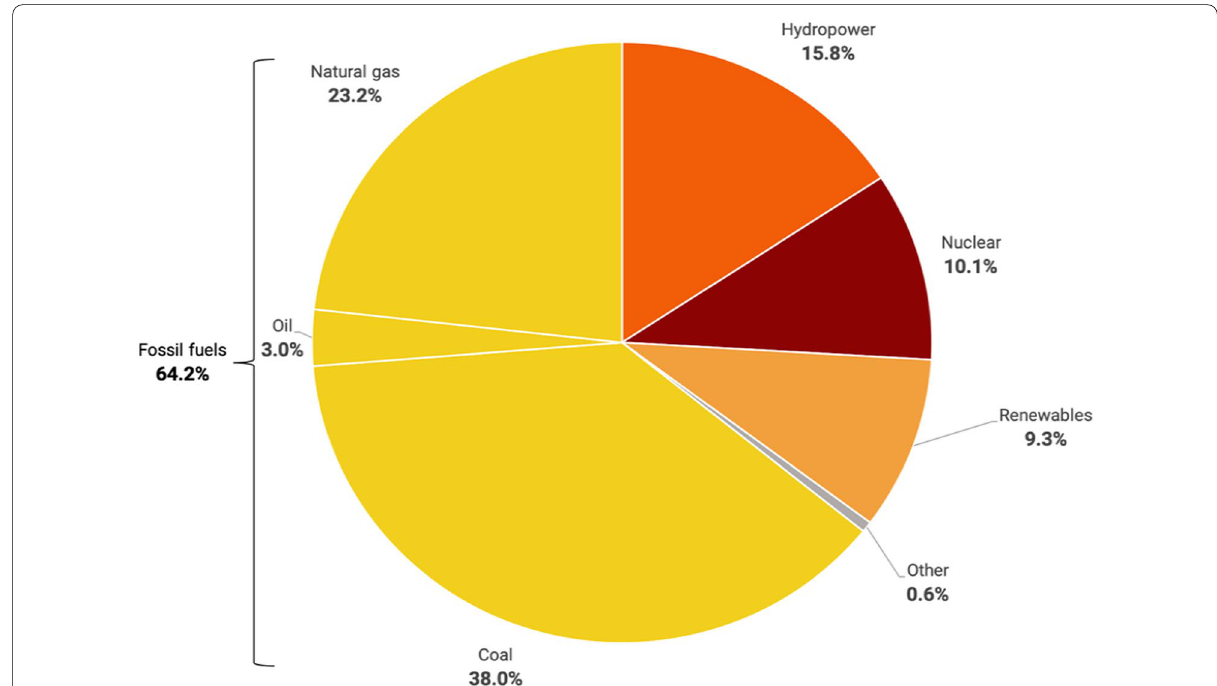
Fig. 1 Sources of global electricity generation (BP